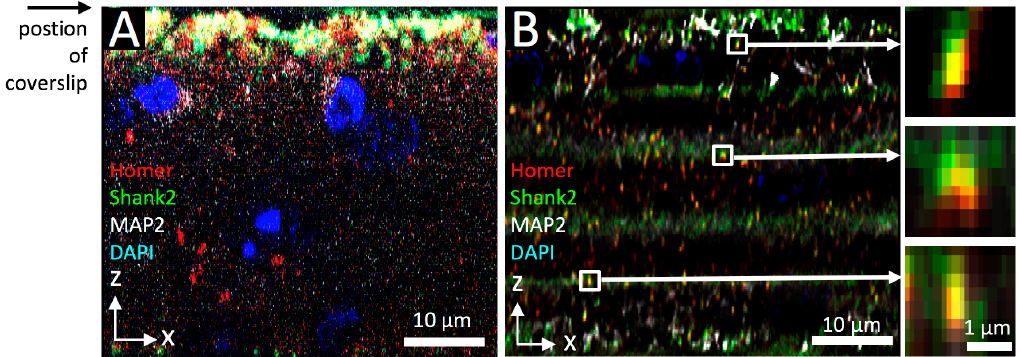
Figure 4. Comparison of optical sectioning and confocal / deconvolution microscopy in synapse imaging of mouse brain tissue. Image stacks of mouse brain labeled to detect Homer (red), Shank2 / ProSAP1 (green) and MAP2 (white) were acquired with SIOS (ApoTome) microscopy ( A ) or SPDM / deconvolution ( B ). DNA was counterstained with DAPI (blue). Images show orthogonal views of each image stack. Single accumulations of colocalized Homer and Shank2 fluorescence, likely representing PSDs, were selected (white box in B ) and shown as enlarged x / z views on the left side of B .